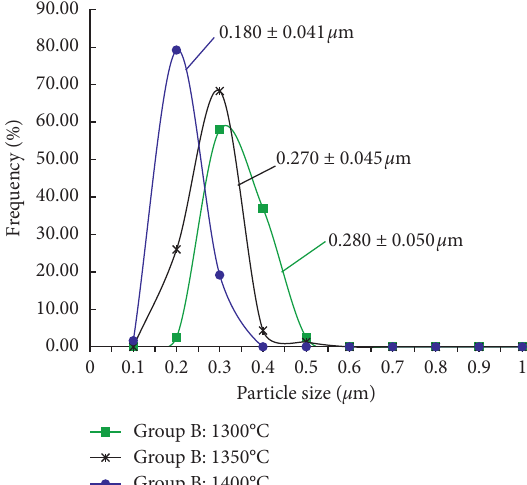
Figure 10: Statistics of particle size distribution of three ceramic rings of group B obtained at different microwave sintering temperatures.